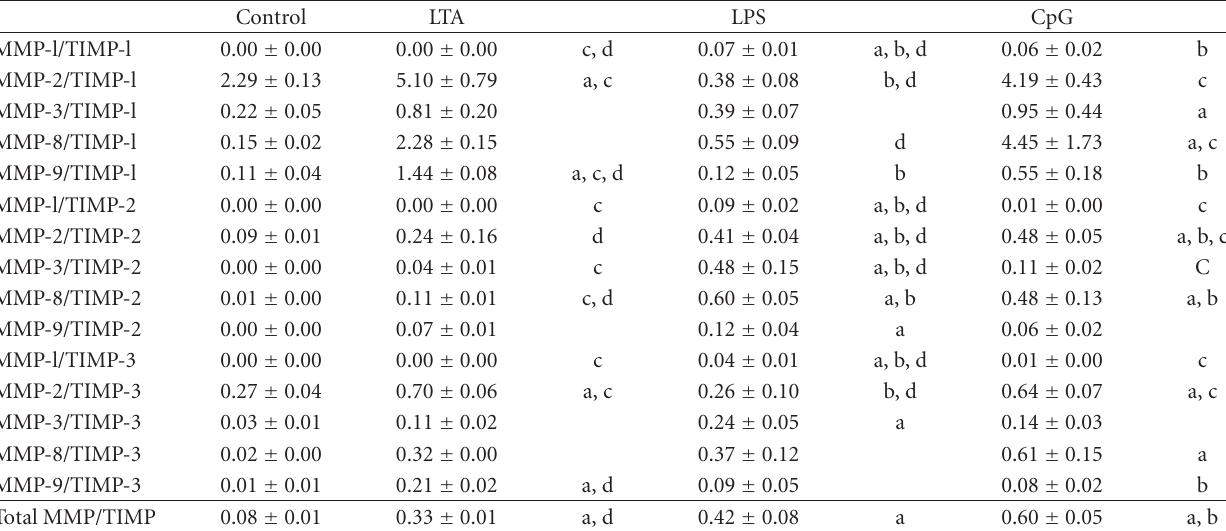
Table 2: MMP/TIMP mRNA ratios. MMP/TIMP mRNA ratios in control, LTA-, LPS- and CpG-stimulated pulmonary tissue. Values of mRNA expressions are normalized to L32 and expressed as arbitrary units (AU). Alphabetic characters indicate P -values < . 05 from Bonferroni post-hoc testing (a = versus control, b = versus LTA, c = versus LPS, d = versus CpG-ODN; M ± SEM; n =